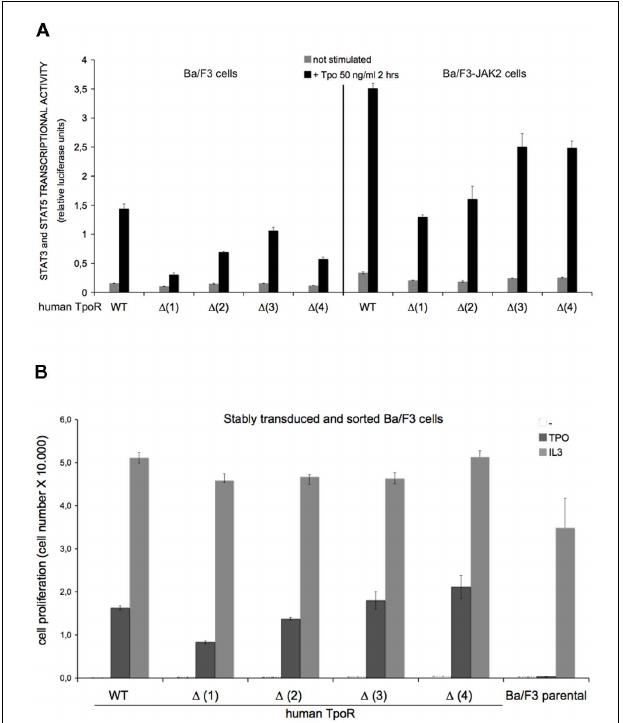
FIGURE 3 | Effect of single N-glycosylation site removal on the Tpo-dependent transcriptional activation of humanTpoR. (A) Ba/F3 or Ba/F3-JAK2 cells expressing stably expressing each humanTpoR defective in single N-glycosylation site [ Δ (1), Δ (2), Δ (3), Δ (4)] were starved 3h in RPMI medium + 1mg/ml BSA and electroporated with the luciferase reporters pGRR5-luc and pRLTK-luc.The cells were stimulated with 50ng Tpo/ml or left unstimulated for 2h. Upon treatment the cells were lysed and their luminescence recorded. Results are the mean ± variation of triplicate samples. One of three independent experiments is depicted.The t -test showed statistically significant differences for theTpo-dependent transcriptional levels of theTpoR mutants when compared with theWT TpoR ( p < 0.05 for all theTpoR variants). Of importance, when Tpo-dependent Δ (1)TpoR transcriptional activity in the stimulated condition was compared with the transcriptional activity of the stimulatedWTTpoR, the p value equaled 0.0086. (B) Ba/F3 stably transduced cells for each of theTpoR variants [ Δ (1), Δ (2), Δ (3), and Δ (4)] were washed three times and seeded in 96-well plates at a density of 3,000 cells/well.The cells were stimulated with 5ngTpo/ml, or with 5ng IL3/ml or left unstimulated during 72h. After 72h, the proliferation of the cells was determined by the DNA synthesis assay reflected by the measurements of the thymidine incorporation as described in Experimental procedures. Results are the mean ± variation of triplicate samples. One of three independent experiments is depicted.The t -test showed significant differences between theTpo-dependent proliferations level of Δ (1)TpoR ( p = 0.0001) and Δ (2) TpoR ( p = 0.0019) when compared